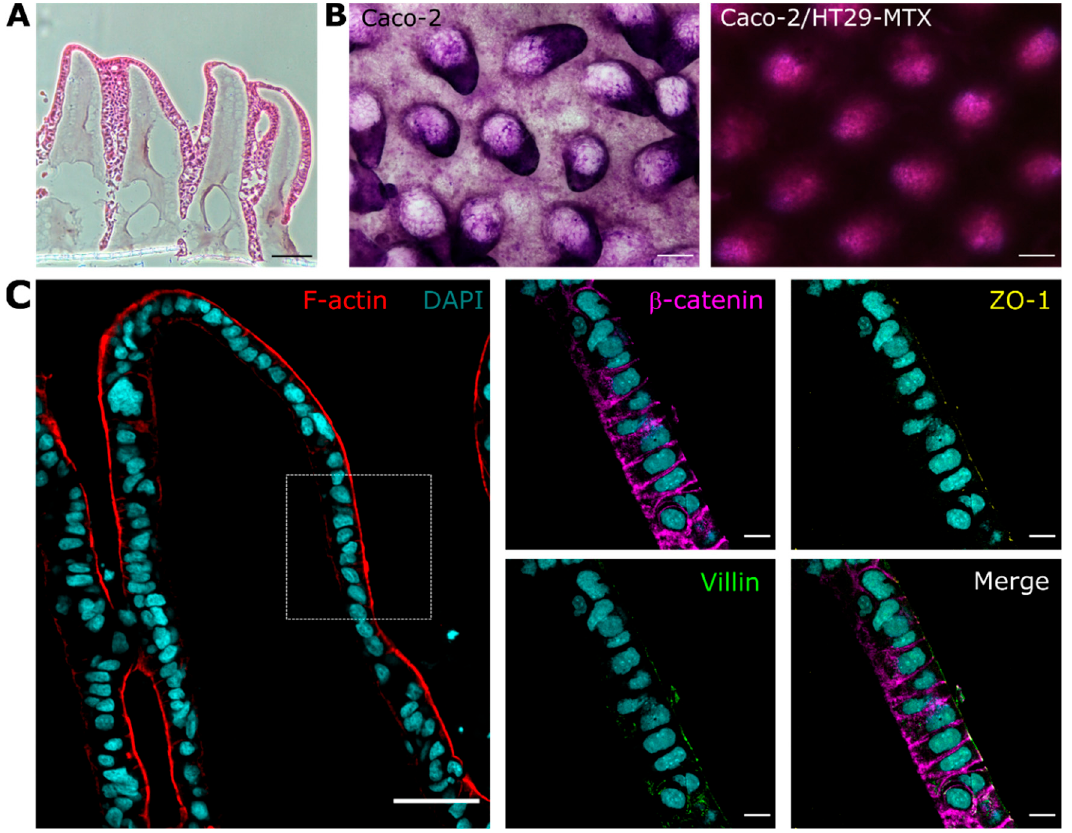
Figure 2. Characterization of the 3D villus-like co-culture model. ( A ) HE staining of the 3D villus- like model with the co-culture of Caco-2/HT29-MTX cells after 2 weeks of culture. Scale bar = 100 μ m. ( B ) Periodic acid-Schiff (PAS) staining of the monoculture of Caco-2 (left) or the Caco-2/HT29-MTX co-culture (right) after 2 weeks of culture. Scale bars = 200 μ m. ( C ) Confocal images of the cross-section of Caco-2/HT29-MTX co-culture grown on top of the villus-like microstructures for 2 weeks. F-actin is shown in red and nuclei in cyan. Scale bar = 50 μ m. The doted box region is shown in high magnification (right panels). The polarization marker β -catenin is shown in magenta, ZO-1 in yellow, and villin in green. Scale bars = 10 μ m.